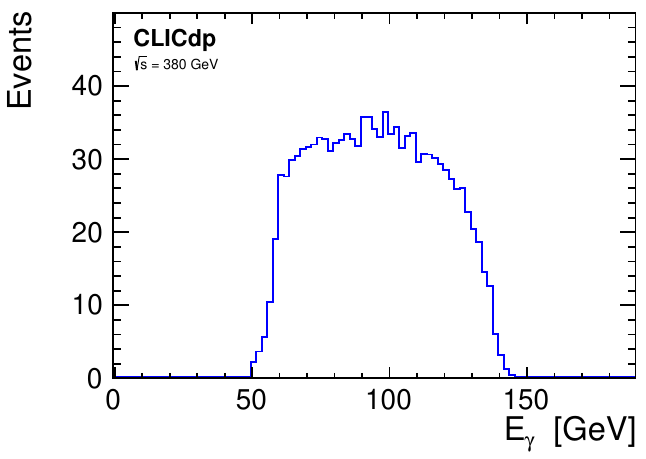
Figure 26. Distribution of the reconstructed photon energy for events with FCNC top-quark decay t ! c g at 380 GeV CLIC. The signal sample is normalised to 1.0 ab (cid:0) 1 and BR(t ! c g ) = 10 (cid:0) 3 .